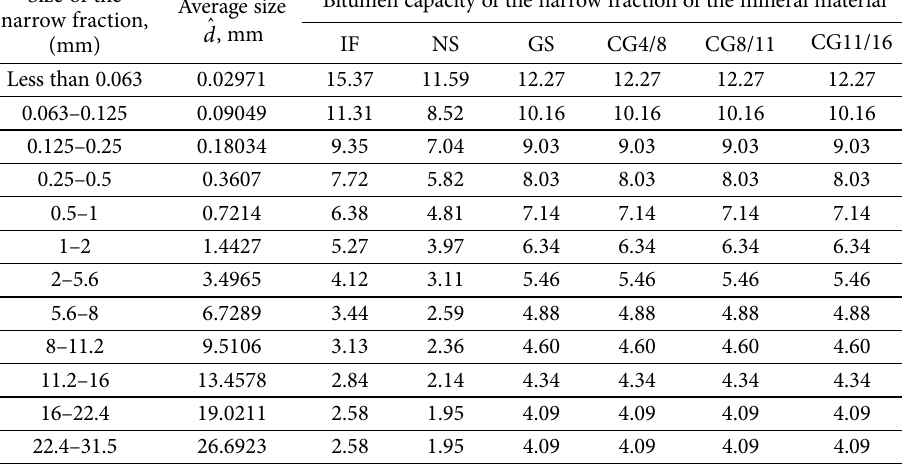
Table 4. Bitumen capacities (%) of the narrow fractions of mineral materials calculated from regression equations presented in Figure 2 Size of the Bitumen capacity of the narrow fraction of the mineral material Average size narrow fraction, ˆ d , mm IF NS GS CG4/8 CG8/11 CG11/16 (mm) Less than 0.063 0.02971